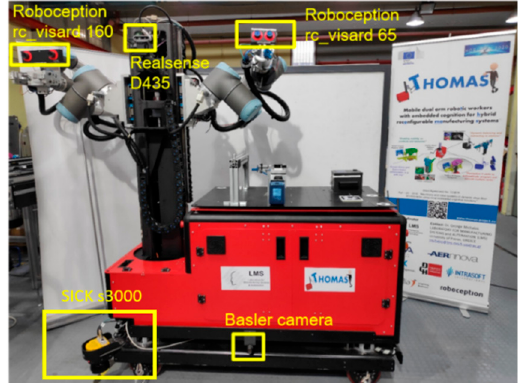
Figure 14. Onboard sensors .